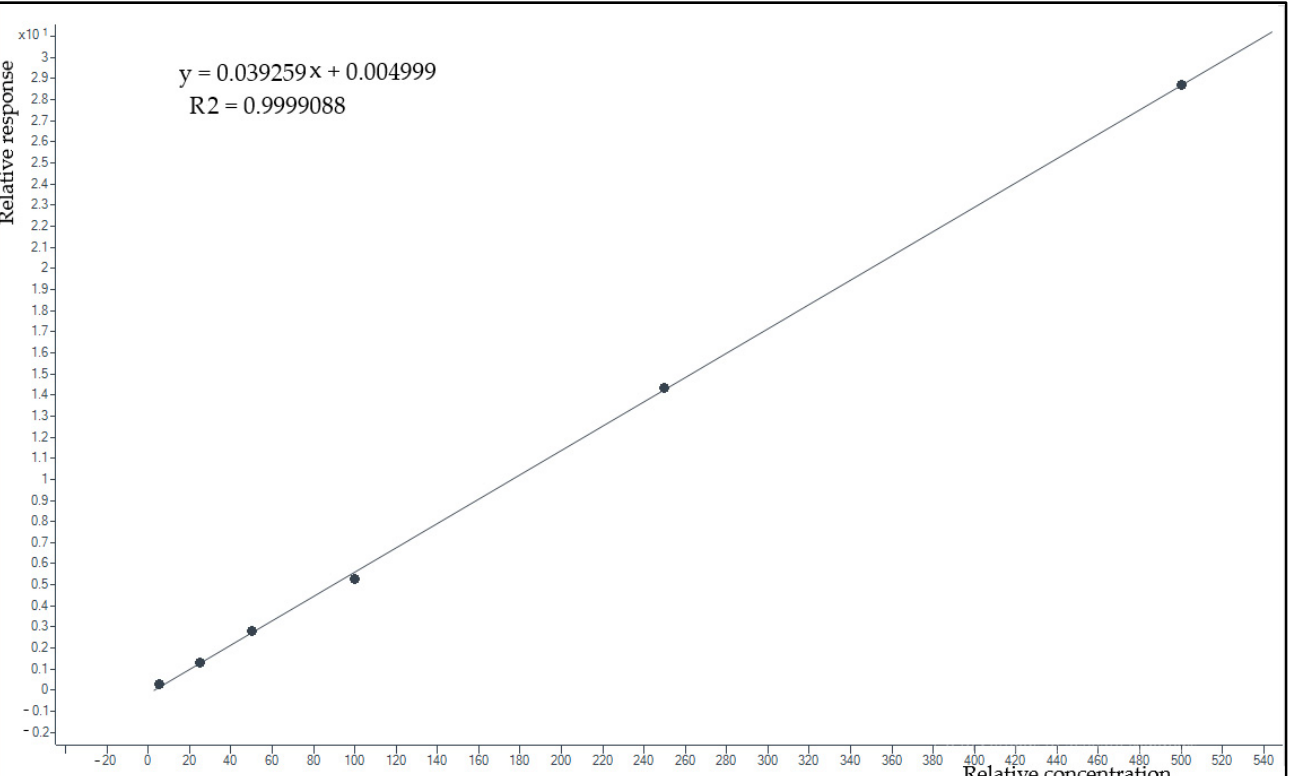
Figure 5. Example of a calibration curve obtained by plotting the DBV/DBV-d6 area ratio (response) over concentration in the 0.125–500 mg/L range. The linear fitting of the six calibration points and the very high correlation coefficient show the stringent linearity of the calibration model.